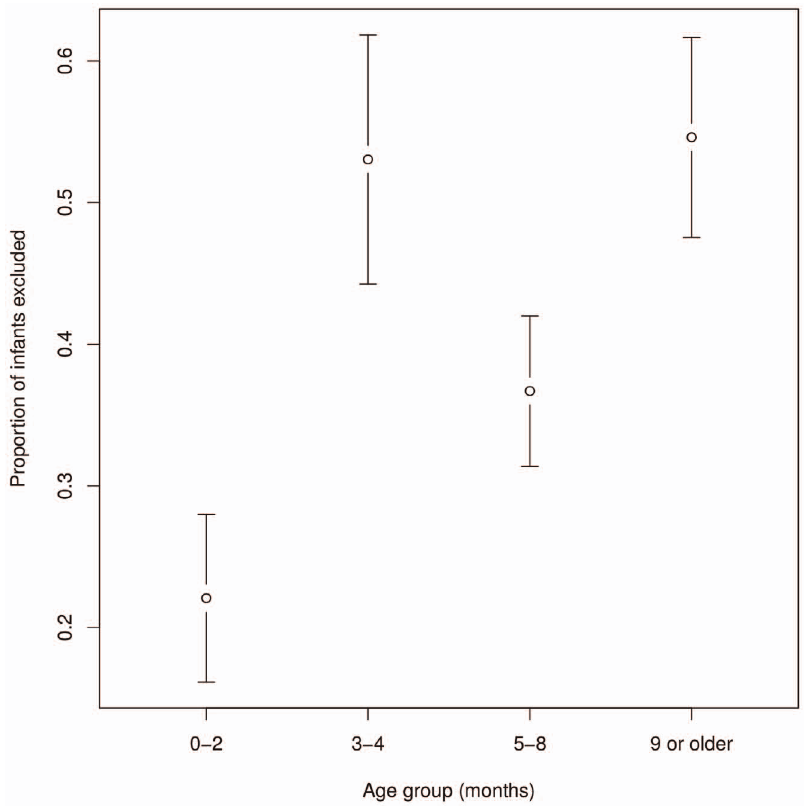
Figure 3. Proportion of infants excluded by age group. Error bars indicate 95% confidence intervals.